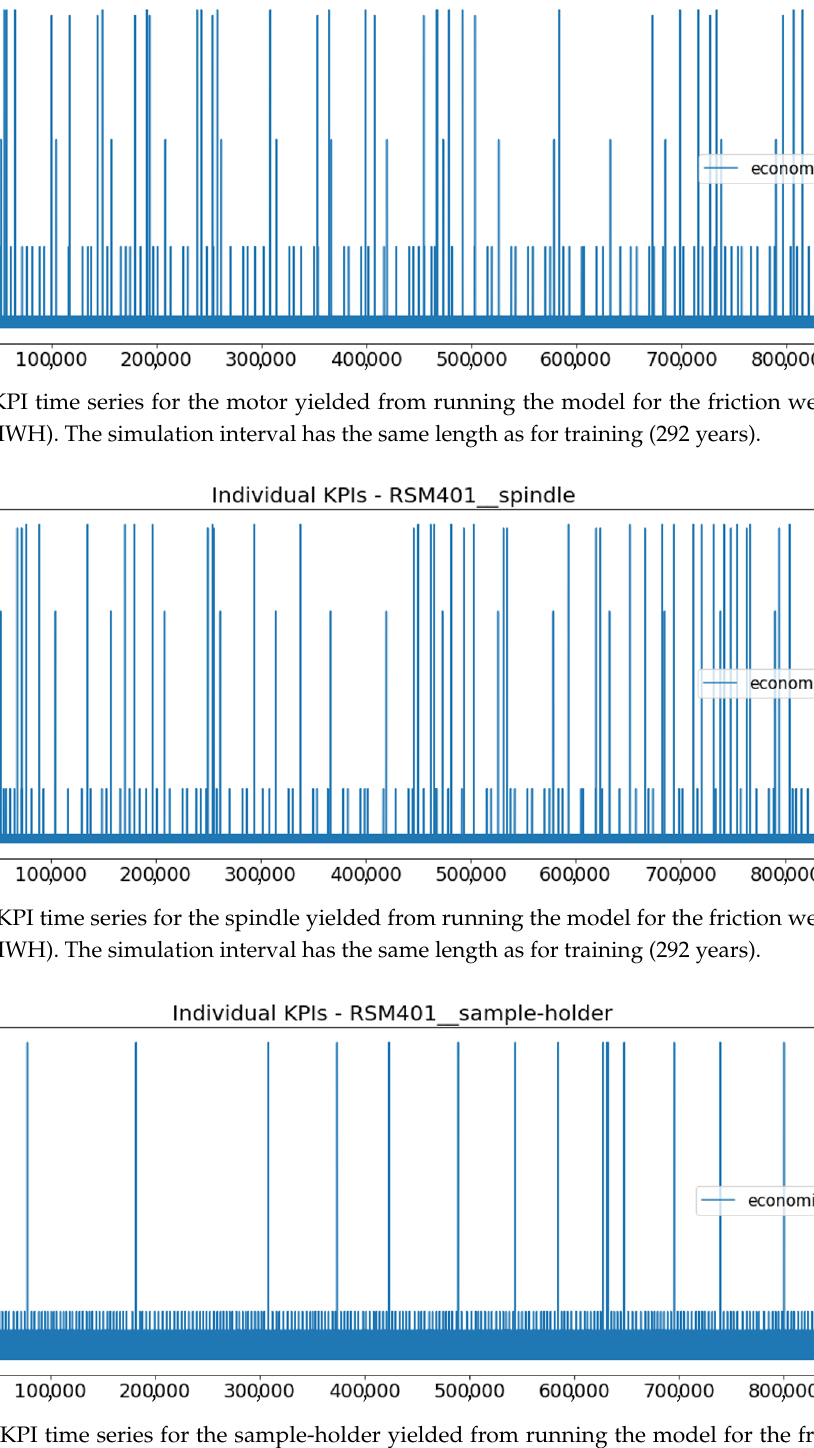
Figure 11. KPI time series for the sample-holder yielded from running the model for the friction welding machine (HWH). The simulation interval has the same length as for training (292